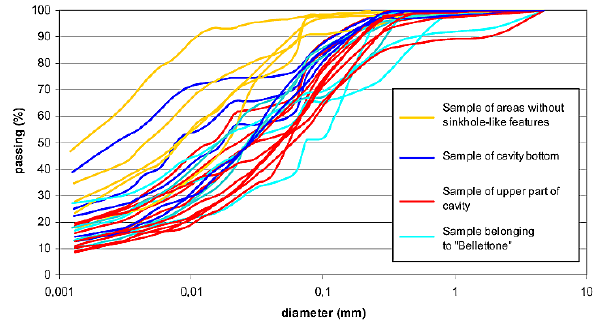
Fig. 10. Grain size distribution of the samples collected in the Pa- ganico area.